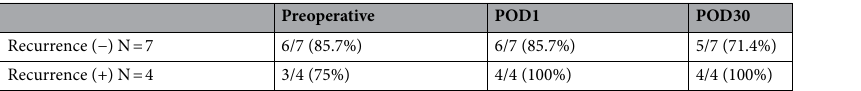
Table 3. Relationship between BRAF V600E detection and recurrence. The cutoff value of the mutant allele frequency was 0.15%. POD postoperative day.